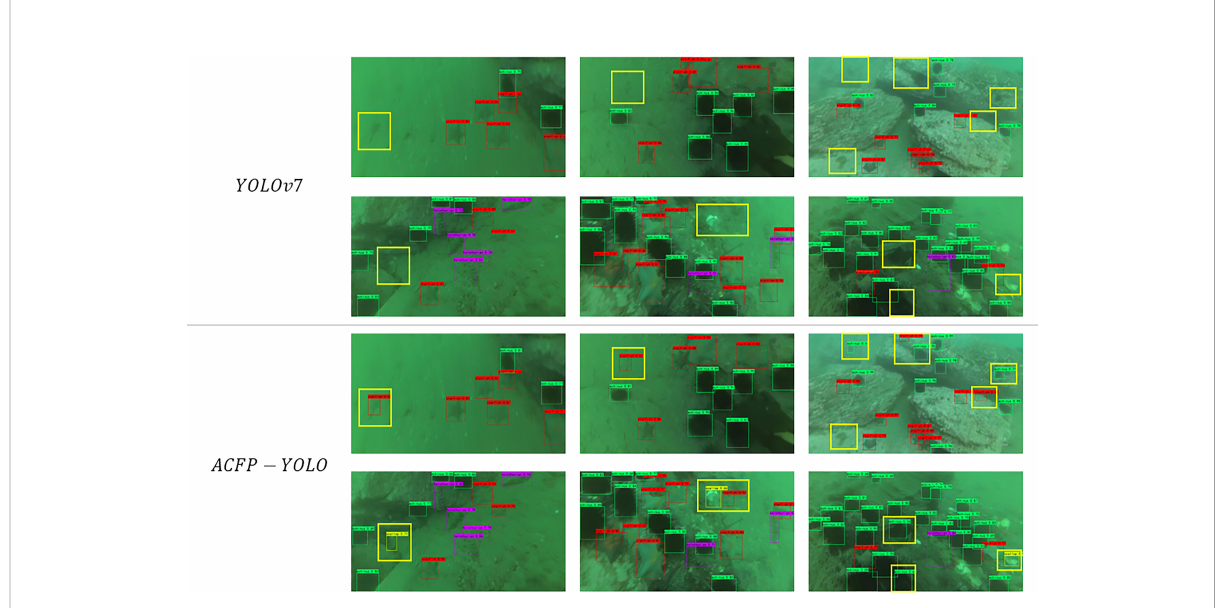
FIGURE 8 The detection effect of YOLOv7 and the detection effect of